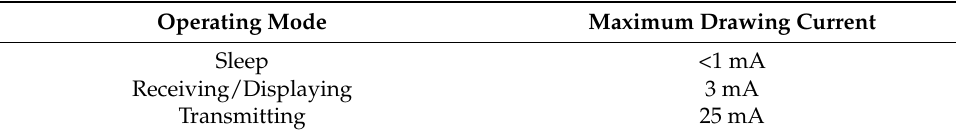
Table 4. Maximum ratings for different operating modes of the